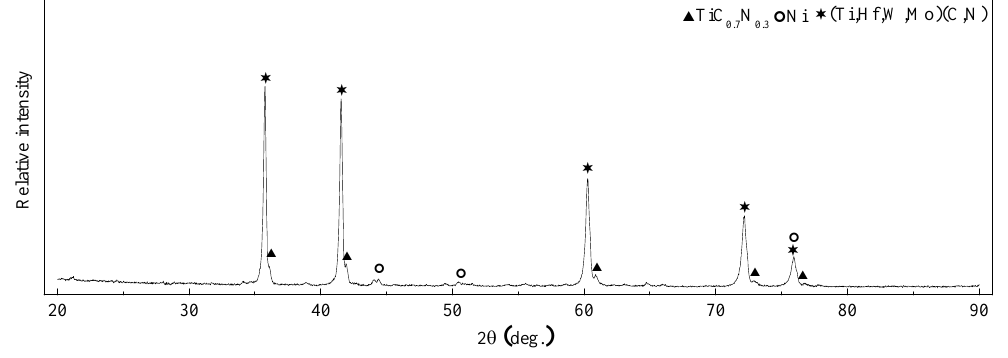
Figure 1. R ‐ ray diffraction (XRD) patterns of TiC 0.7 N 0.3 ‐ HfC ‐ WC ‐ Ni ‐ Mo cermet tool materials. Figure 1. R-ray diffraction (XRD) patterns of TiC 0.7 N 0.3 -HfC-WC-Ni-Mo cermet tool